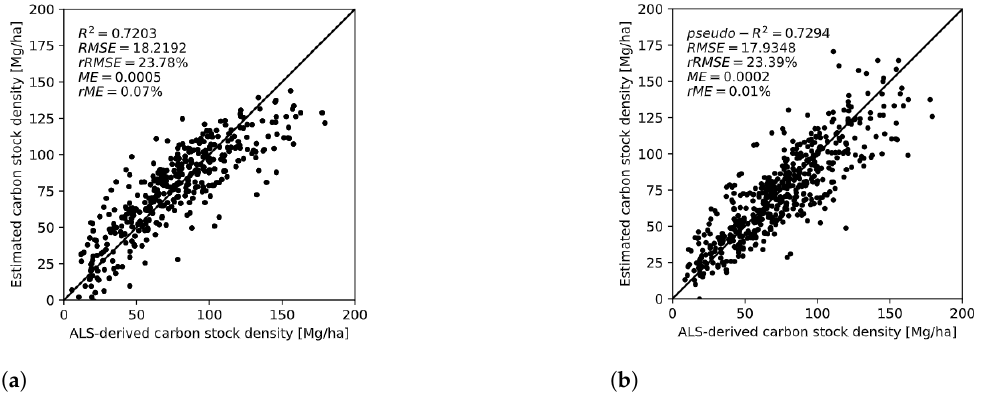
Figure 8. Relationships between the carbon stock density estimates using optical satellite imagery and space LiDAR fusion and the ALS-based carbon stock density on the validation dataset. ( a ) Linear regression; ( b ) regression with log